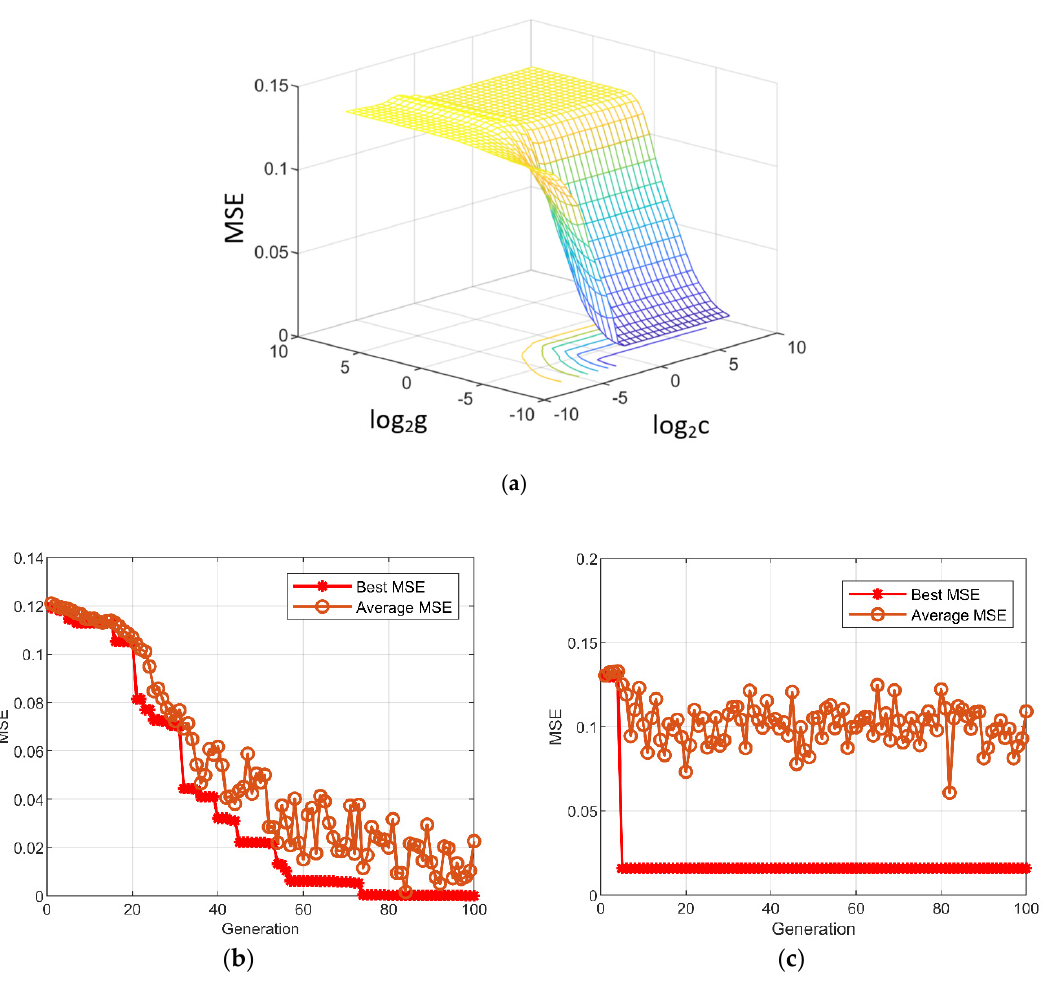
Figure 12. ( a ) Grid search method; ( b ) GA method; ( c ) PSO method. GA, genetic algorithm, PSO, particle swarm optimization. Table 4. Comparison of SVR indicators under different algorithms. GS-SVR, support vector regression optimized by grid search method; GA-SVR, support vector regression optimized by genetic algorithm; PSO-SVR, Support vector regression optimized by particle swarm optimization.